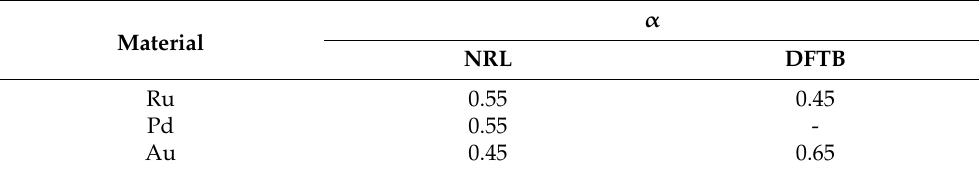
Table 1. Parameter α of the linear dependence of the coupling on T a in Equation